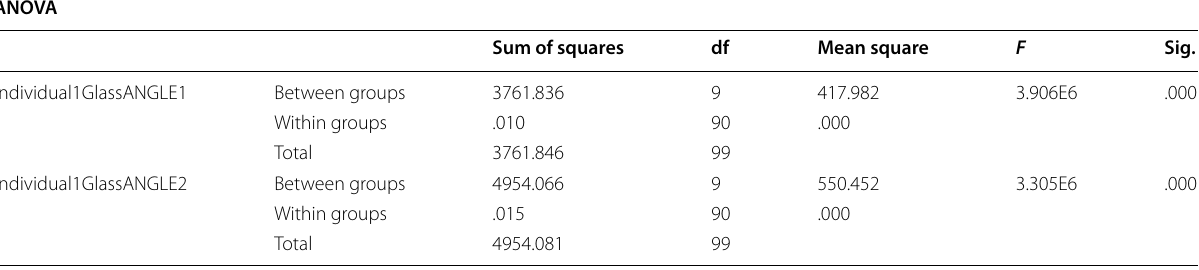
Table 12 Results obtained using ANOVA for fingerprints obtained from the left thumb of individual 1 on glass with “angle” as the “dependent variable” ANOVA Sum of squares df Mean square